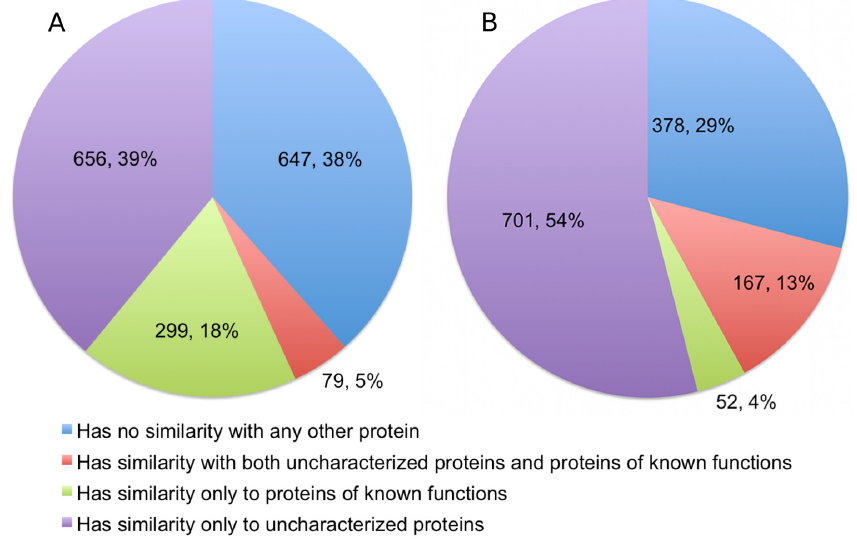
Figure 3. Similarity search results using ( A ) BLAST and ( B ) Dali. Values to the left refer to the number of protein sequences, those on the right refer to the percentage of that